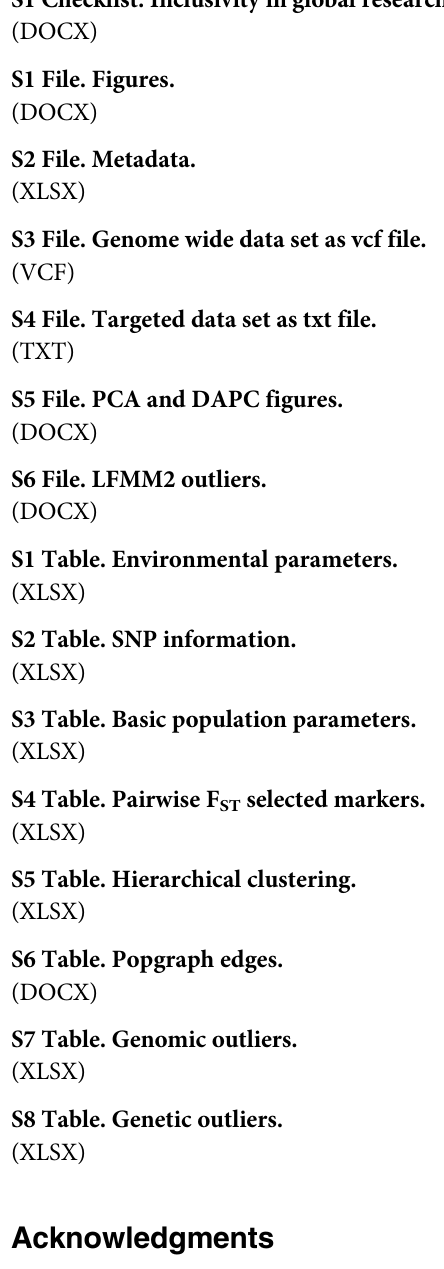
S1 Table. Environmental parameters. S2 Table. SNP information. S3 Table. Basic population parameters. S4 Table. Pairwise F selected markers. ST S5 Table. Hierarchical clustering. S6 Table. Popgraph edges. S7 Table. Genomic outliers. S8 Table. Genetic